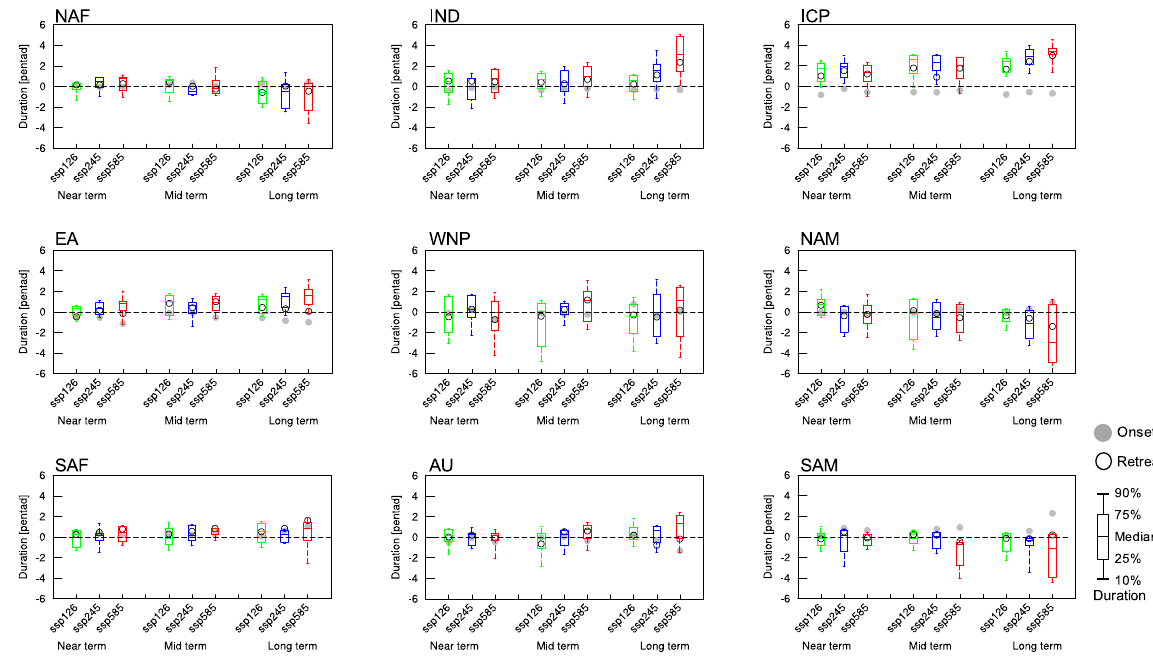
Fig. 3 Changes in length of the rainy season over global monsoon regions. Future changes (unit: pentad) in onset ( fi lled gray circle), retreat (black circle), and duration (box plot) for nine global monsoon domains. The boxes indicate the spread (from the 25th to the 75th percentile; center lines indicate the median) of the CMIP6 models.